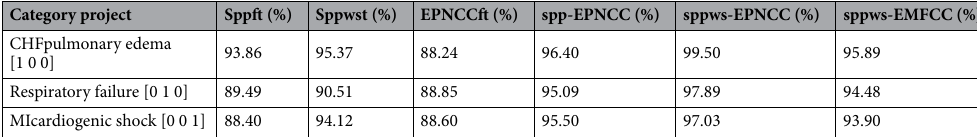
Table 7. F-measure of each training category.